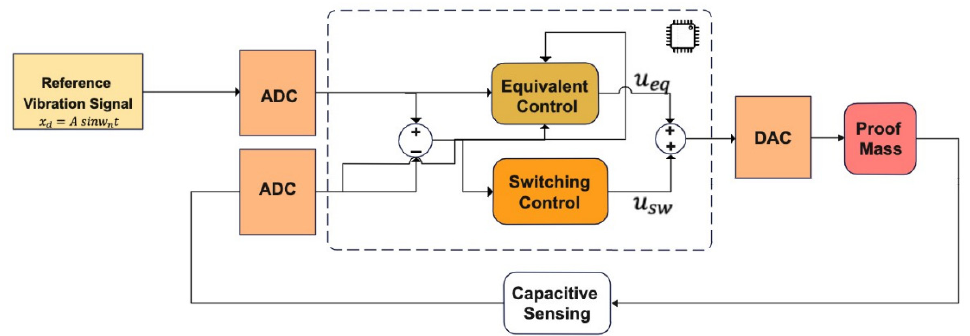
Figure 4. Conventional Sliding Mode Controller.